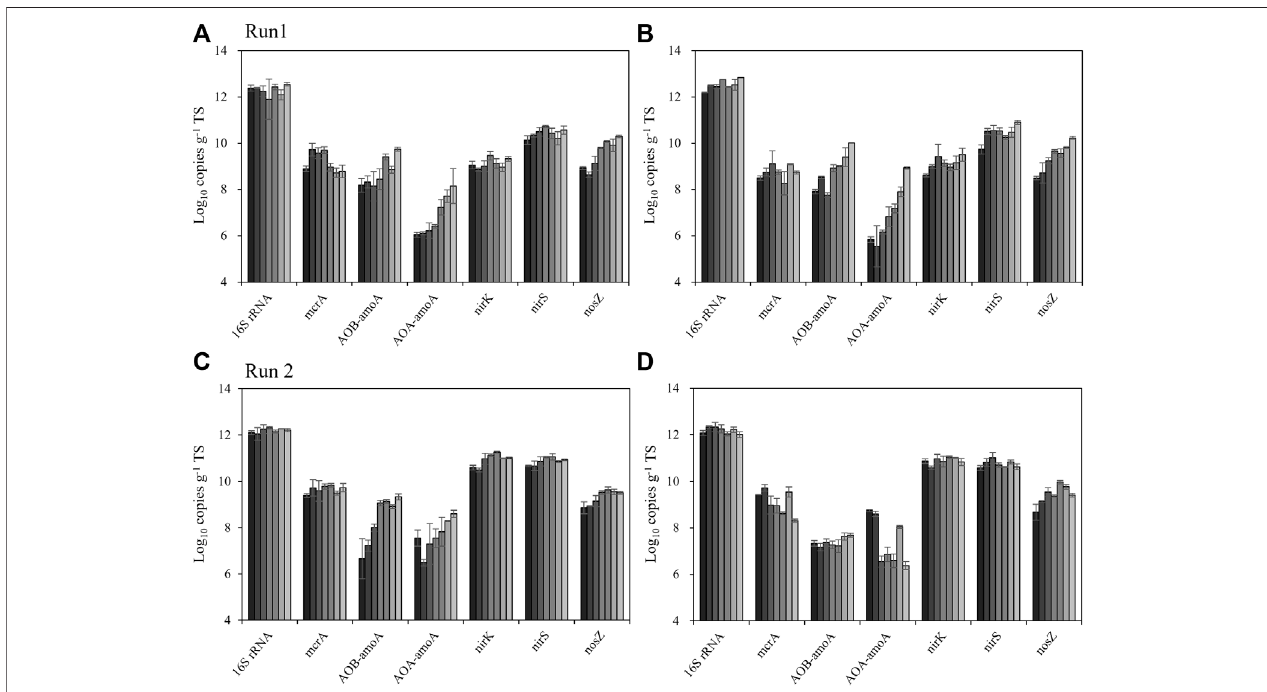
FIGURE 3 | Changes in the abundance of the marker gene (16SrRNA) and functional genes ( mcrA , AOA- amoA , AOB- amoA , nirK , nirS and nosZ ) related to CH 4 and N 2 O emission during the beef cattle manure storage. (A) Run 1, control heap. (B) Run 1, rice straw heap. (C) Run 2, control. (D) Run 2, rice straw heap. Gradient from black to light gray indicates the time, from week 0 to 12. Error bars: SD ( n =